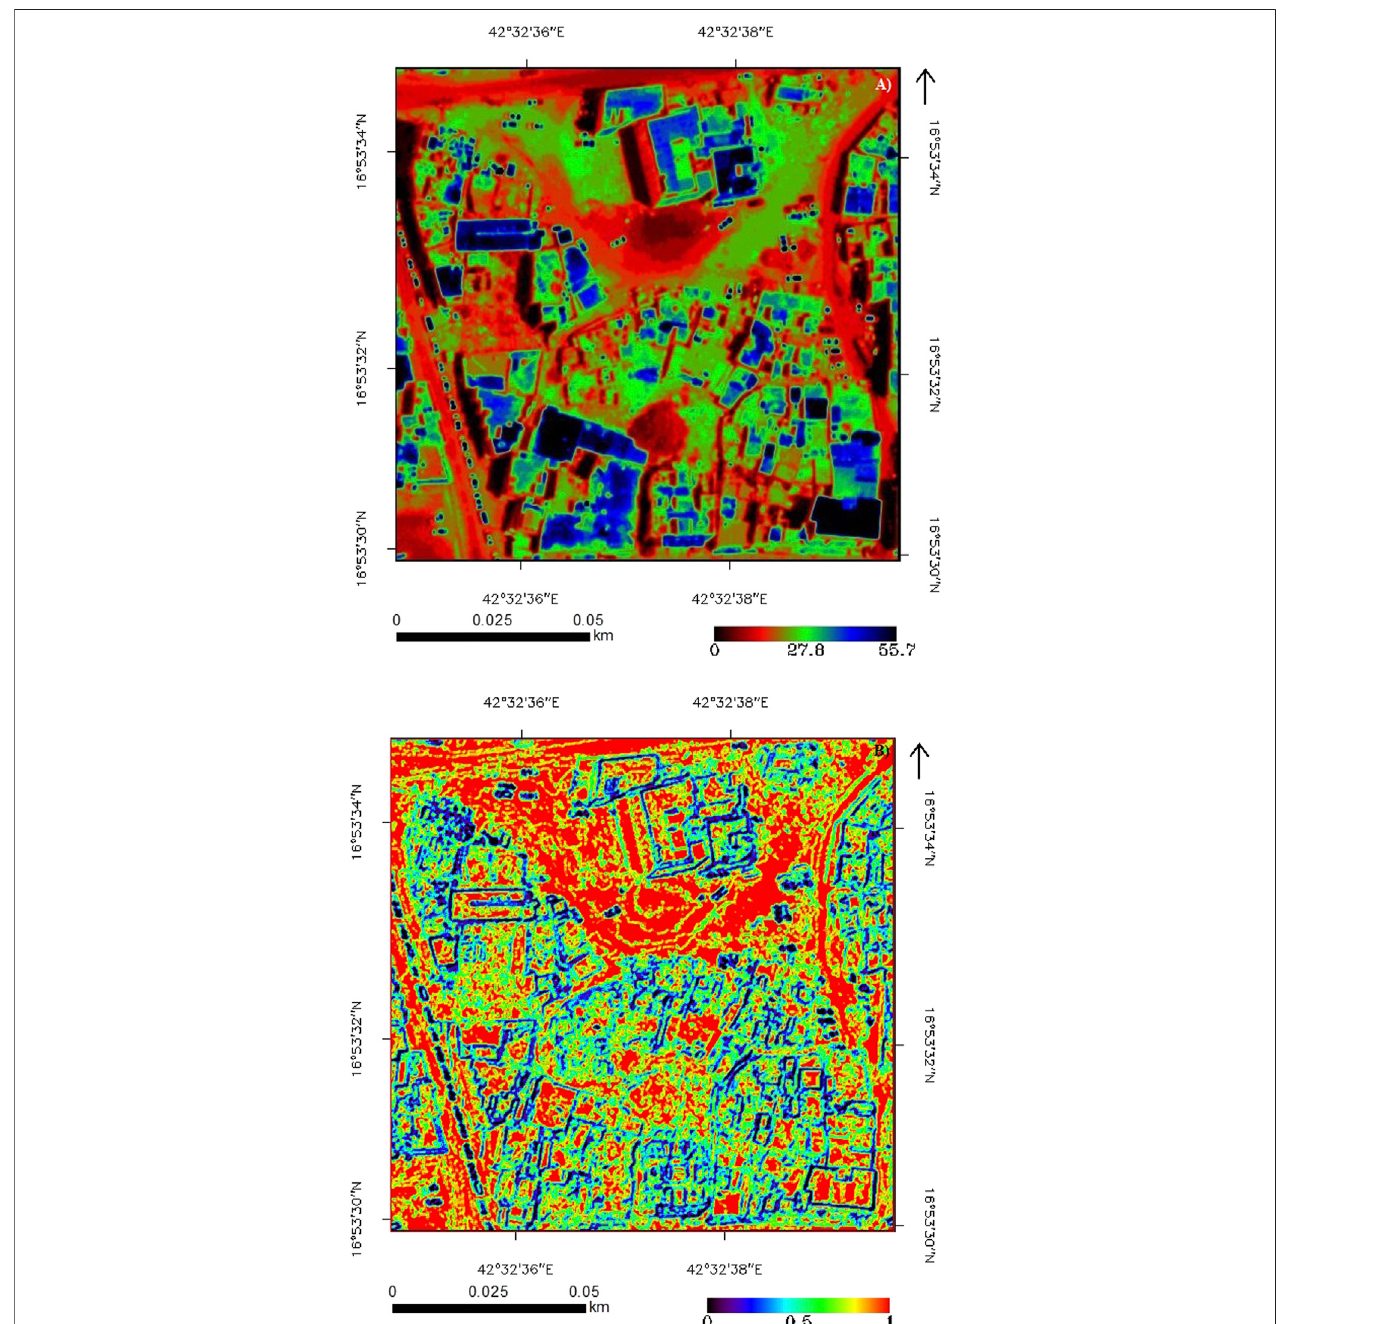
FIGURE 9 | The classi fi cation of buildings based on average (A) and homogeneity (B) images.